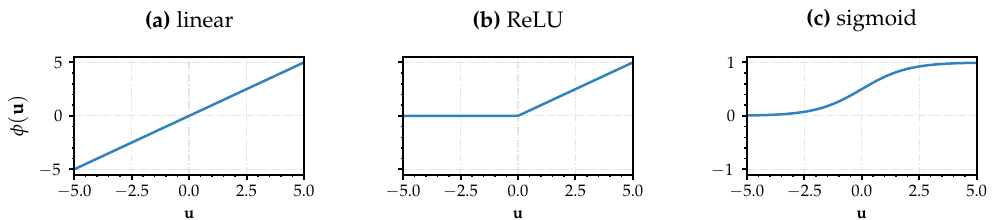
Figure 2. Different activation functions with a linear function ( a ) for comparison with the LDA. Nonlinearity is induced by ReLU ( b ) and sigmoid ( c ) functions as